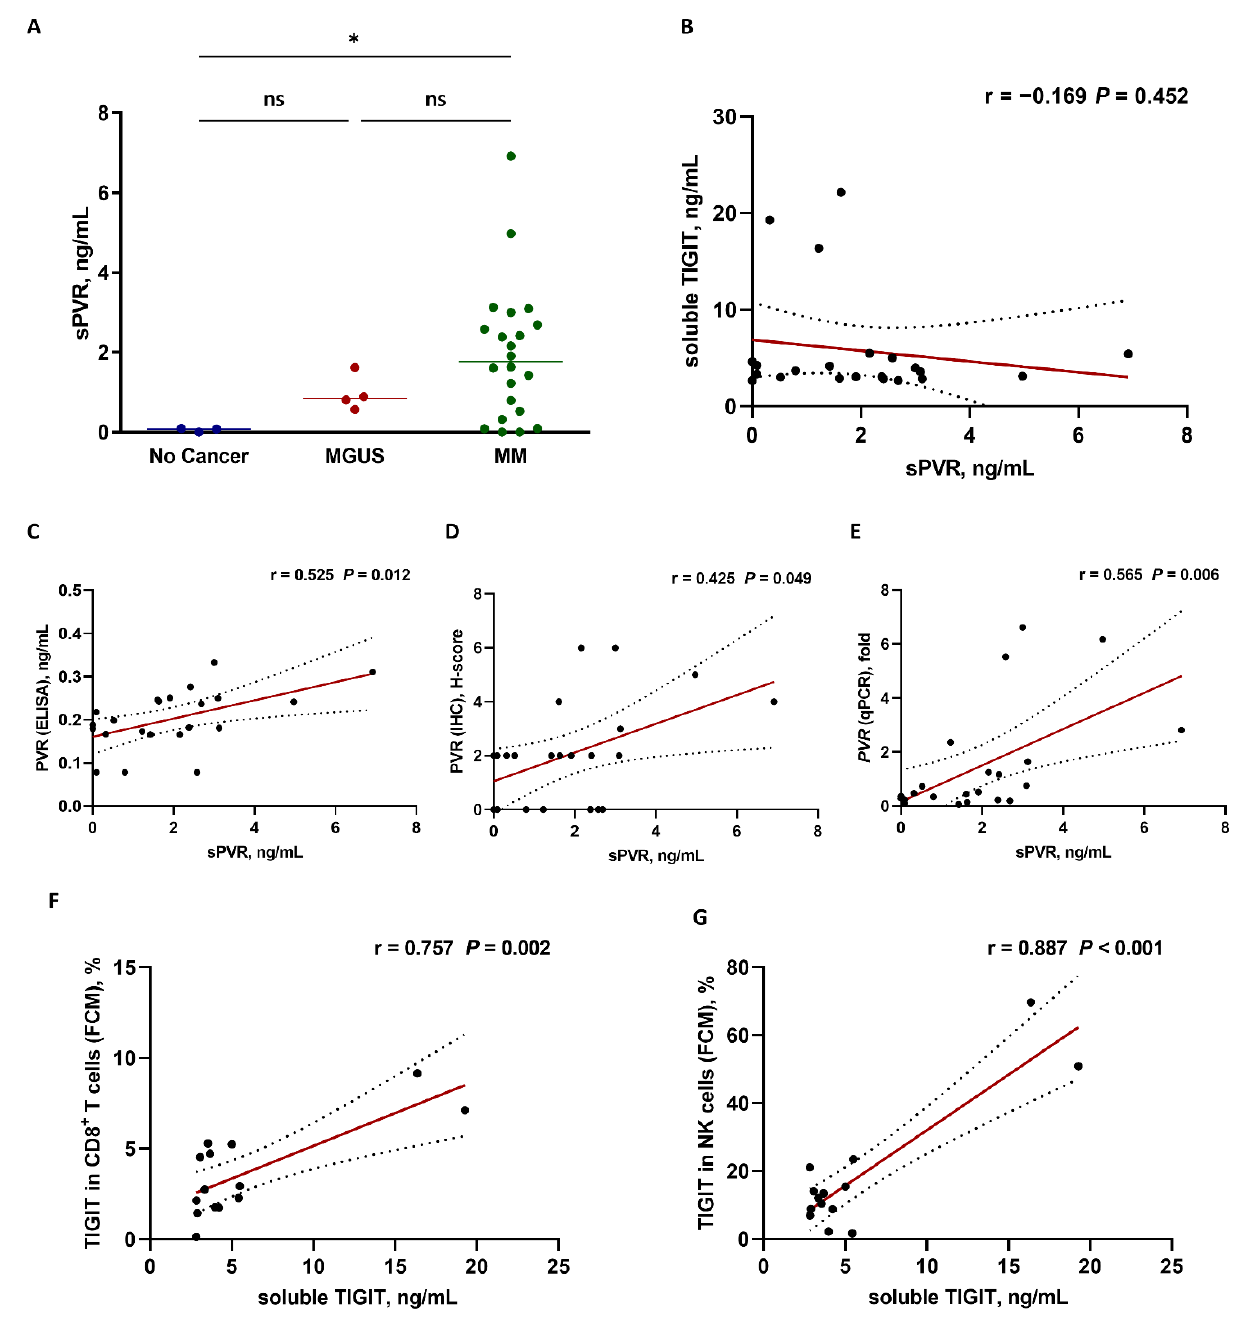
Figure 4. Correlation analysis based on soluble PVR (sPVR) and TIGIT levels in bone marrow plasma from patients with MM. ( A ) sPVR levels from patients without cancer (n = 3), patients with MGUS, (n = 4), and patients with MM (n = 22). * p < 0.05, ns, not significant; Kruskal – Wallis test. ( B ) Relationship between sPVR and soluble TIGIT (n = 22). No significant correlations were observed. Positive correlation between sPVR and PVR expression in bone marrow plasma cells as measured by ( C ) ELISA, ( D ) IHC, and ( E ) qPCR (n = 22). Positive correlation between soluble TIGIT and TIGIT expression in bone marrow ( F ) CD8 + T cells and ( G ) NK cells (n = 14) measured by FCM. Pearson’s or Spearman’s correlation coefficients (r) were used for analyses. Black ball, raw data; Red line, linear fit line; dotted line, 95% confidence band. BM, bone marrow; ELISA, enzyme-linked immunosorbent assay; FCM, flow cytometry; IHC, immunohistochemistry; MGUS, monoclonal gammopathy of undetermined significance; MM, multiple myeloma; PVR, poliovirus receptor; qPCR, quantitative polymerase chain reaction; TIGIT, cell immunoreceptor with Ig and ITIM domains.